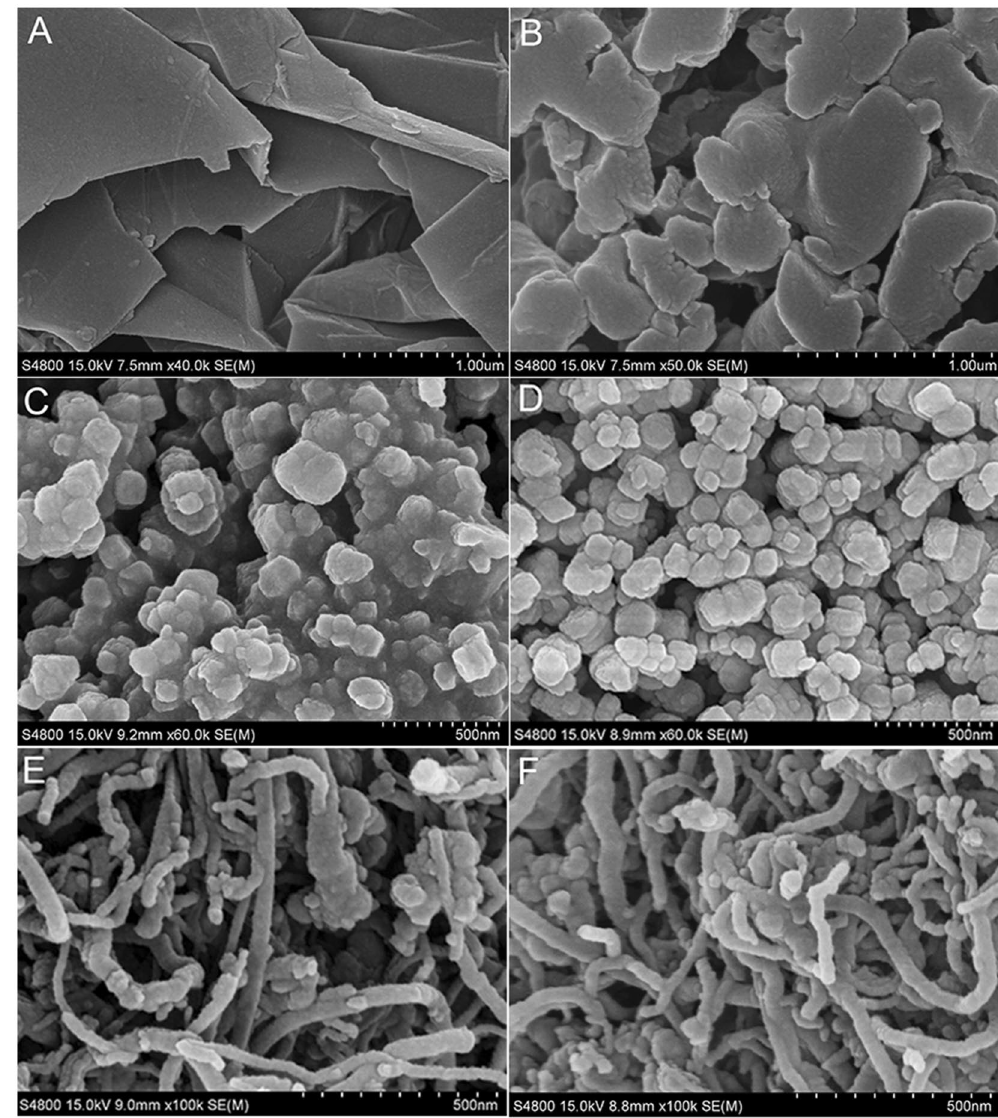
hydrogen phosphate-citrate buffer (pH 7); graphene nanoparticles mass (10 mg) was added in 2 mL of enzyme solution and the mixture was stirred at 120 rpm in an incubator shaker for 3 h, reaction temperatures was 50